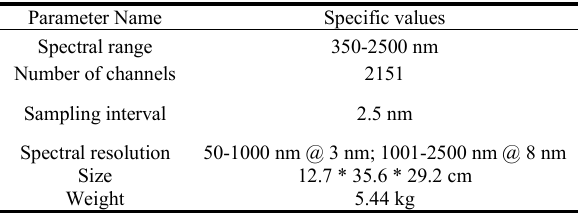
Table 1. Parameters of ASD FieldSpec4 portable spectroradiometer